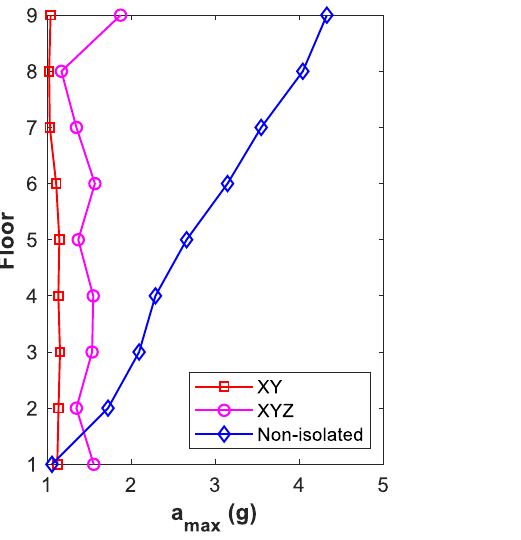
Figure 10. Peak acceleration on each floor under bi- and tri-directional and fixed-base cases: ( a ) the near-source record and ( b ) the far-field record.